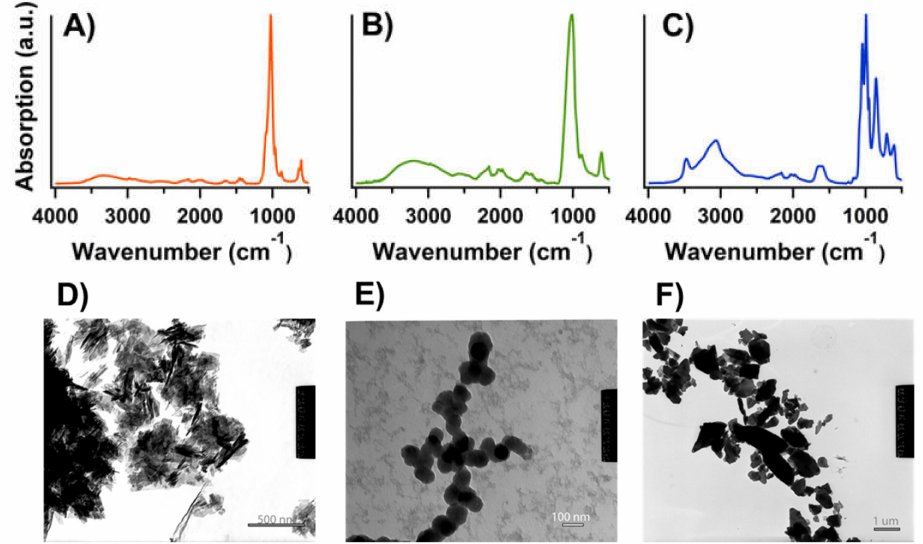
Figure 2. ATR-FTIR (top) and TEM images (bottom) of the brushite / newberyite series: ( A , D ) pure brushite, ( B , E ) Mg-brushite formed from 1:1 (Ca:Mg) solution ratio, ( C , F ) pure newberyite. Larger versions of ATR-FTIR spectra are available in the Supplementary